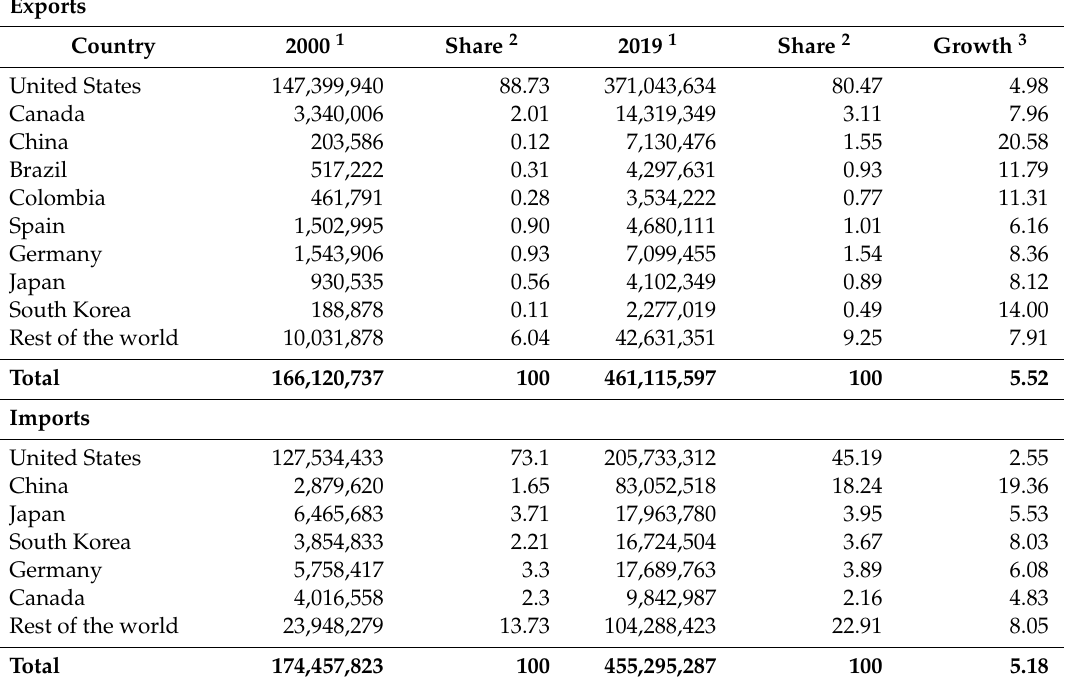
Table 1. Exports and Imports by Country: Mexico